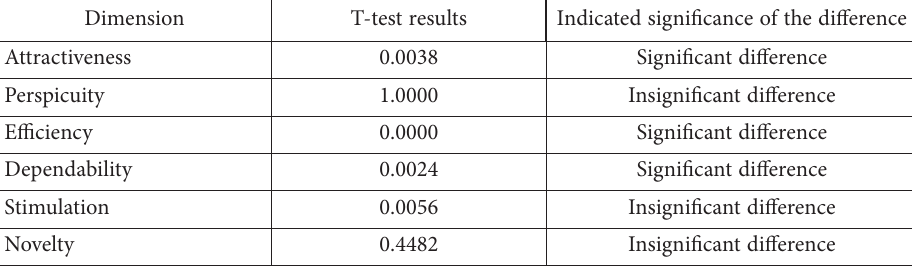
Table 4. T-test results (source: created by the authors)